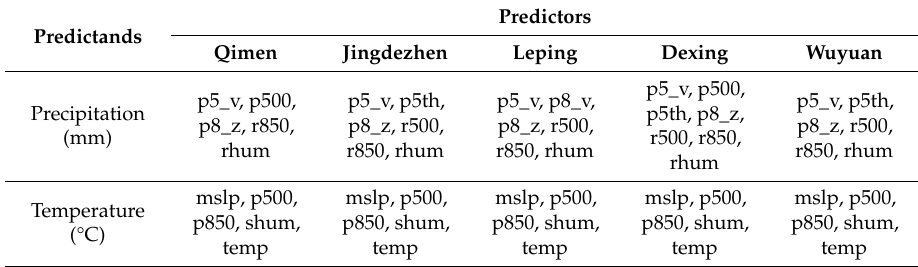
Table 2. Selected predictors for di ff erent predictands of the five meteorological stations in